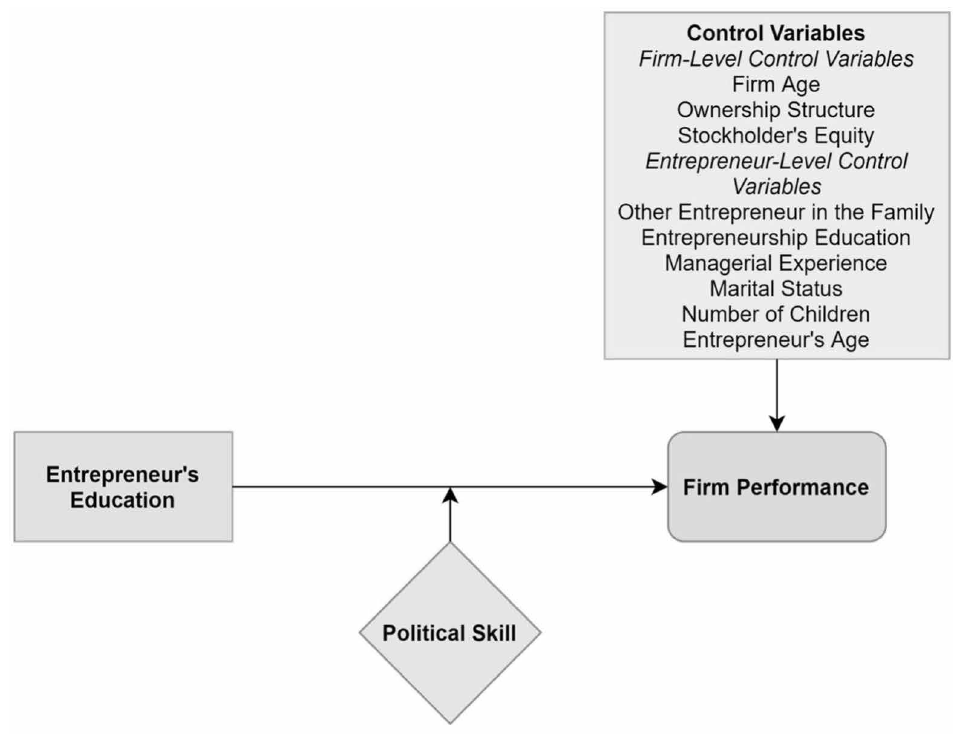
Figure 1. Theoretical